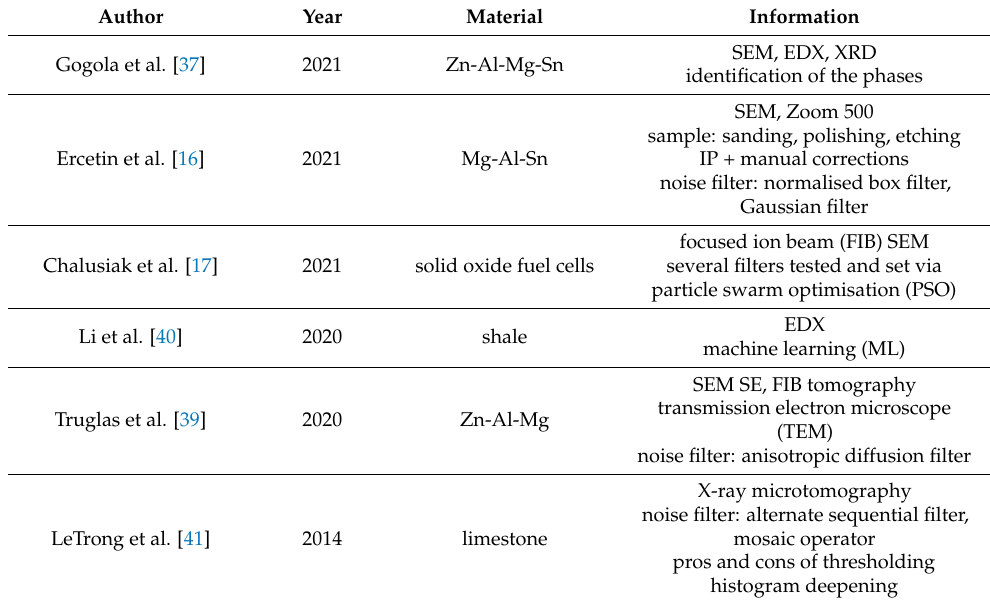
Table 1. Survey of the published